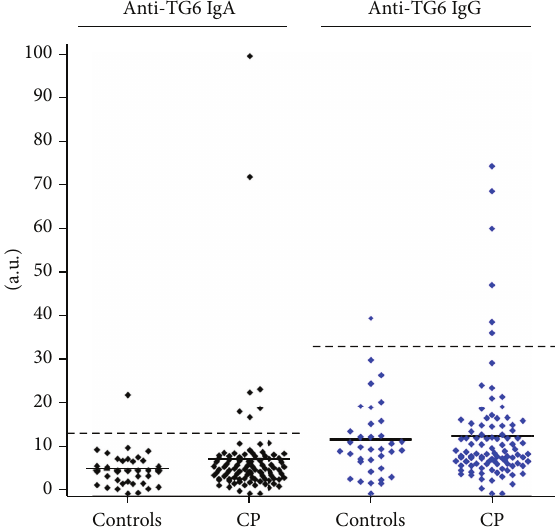
Figure 1: Analysis of serum for antibodies against transglutaminase type 6 (TG6) by ELISA. Relative concentration of antibodies in children ( 𝑛 = 96 ) with cerebral palsy (CP) and controls ( 𝑛 = 36 ) is given in arbitrary units. Bolded line represents the mean titre of the group and dotted line the threshold for a positive test.